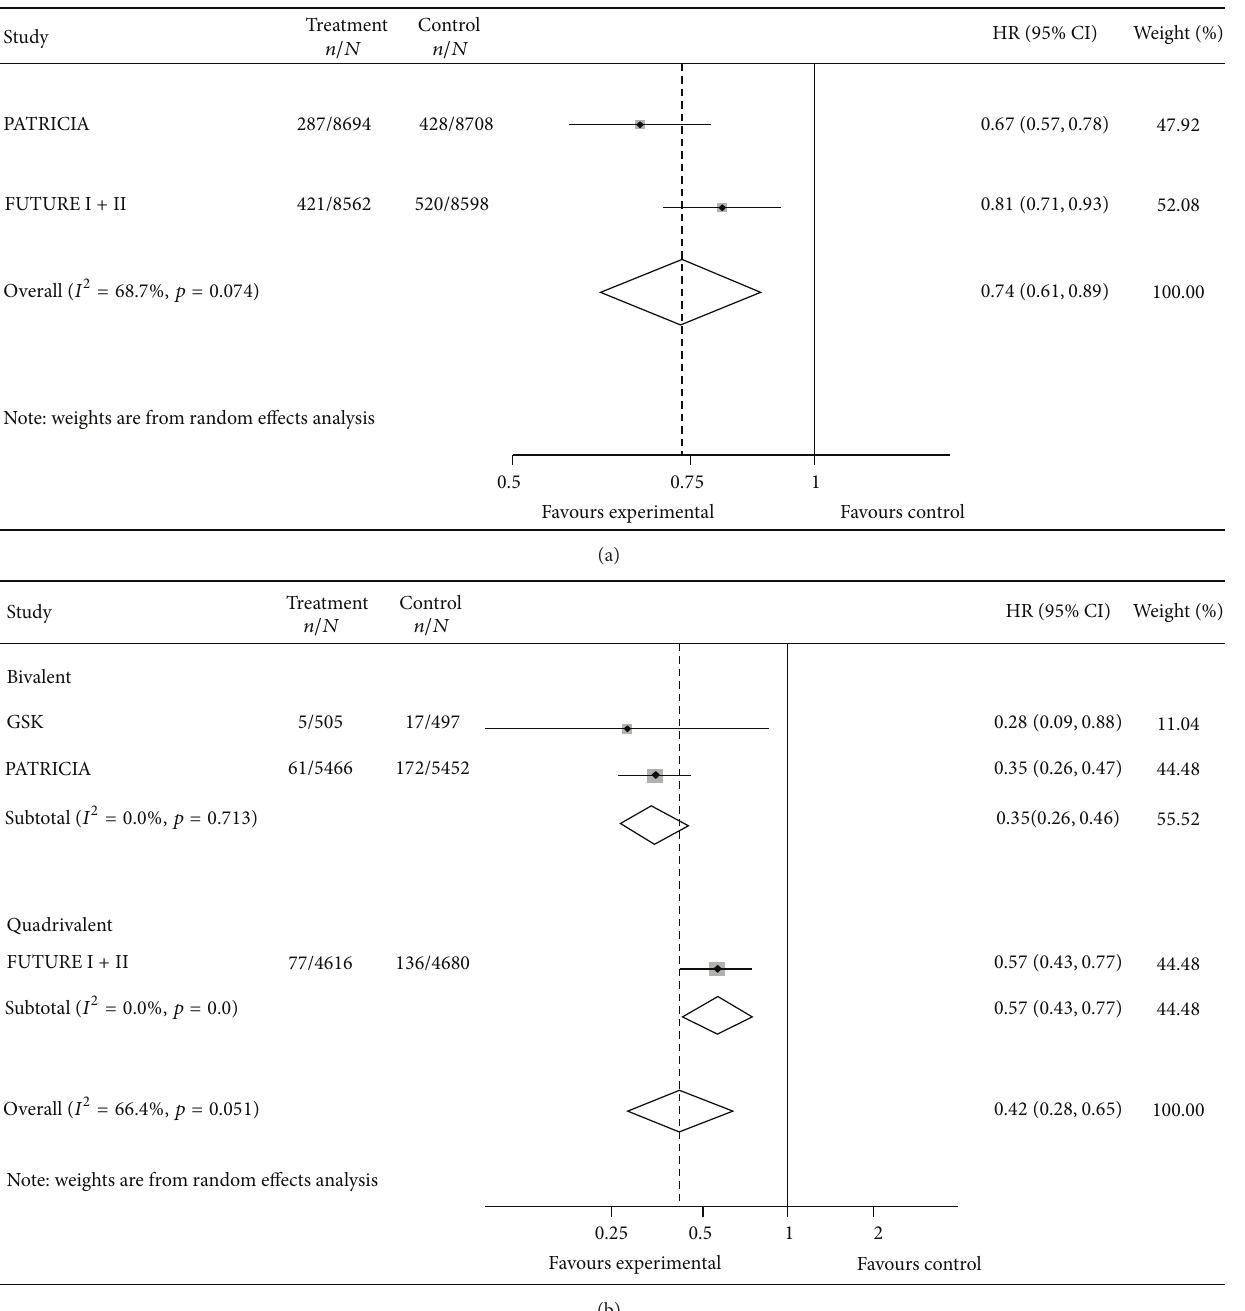
estimate of the efficacy was possible. The pooled HR for lesions associated with any type of HPV was 0.01 (95% CI: 0.01–0.22) resulting in a VE of 99% (95% CI: 78, 99) [26, 27]. For all the comparisons 𝐼 2 suggested low